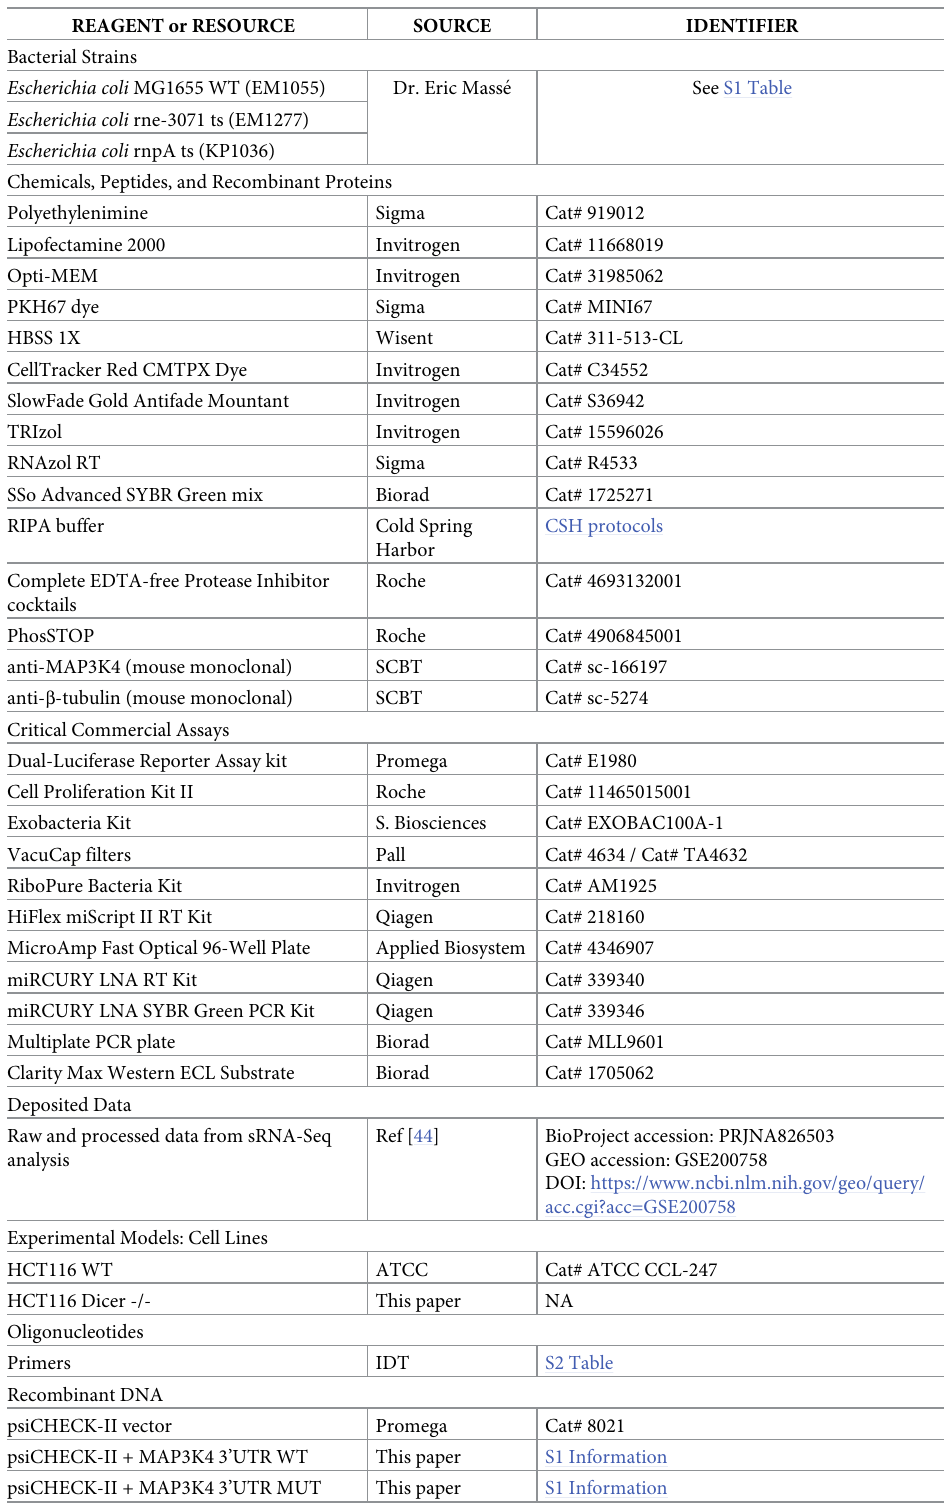
Table 1. STAR $ Methods—Key